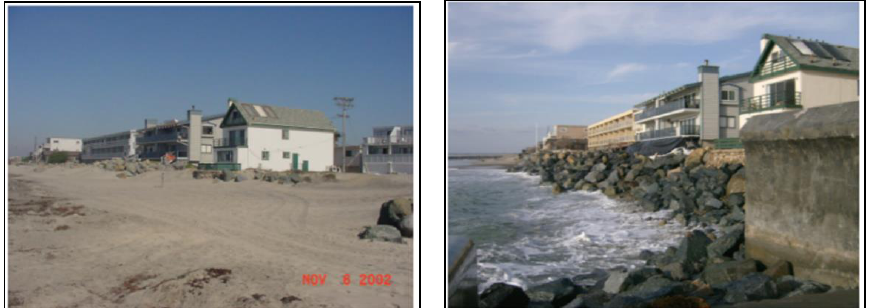
Figure 3. Impact of coastal armoring on public beach—with sand following nourishment ( left ), and without sand ( right ). Photo: J. Nakagawa.